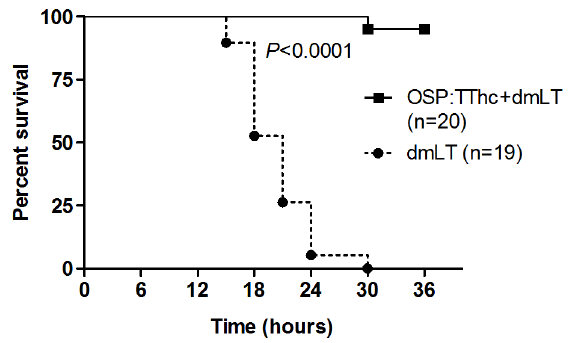
Figure 5. Survival likelihood of neonatal CD-1 mice following oral challenge with wild-type O1 Ogawa V. cholerae O395. Three- to five-day-old pups (cohort size 20) were orally gavaged with 50 m l of a preparation containing 2.3 6 10 9 CFU of wild type V. cholerae O395 mixed with a 1:250 dilution of pooled day 56 serum from mice intramuscularly immunized with conjugate vaccine (OSP:TThc) and immunoadjuvantative dmLT, or dmLT alone. Survival curves were compared by log rank testing.